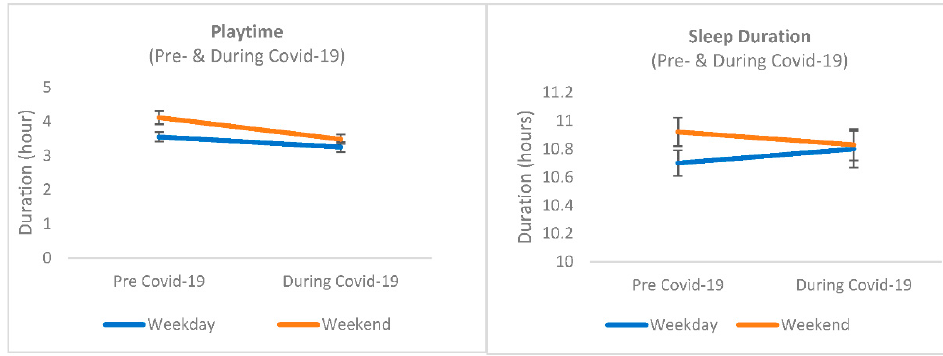
Figure 1. Comparison of playtime and sleep duration before and during COVID ‐ 19.